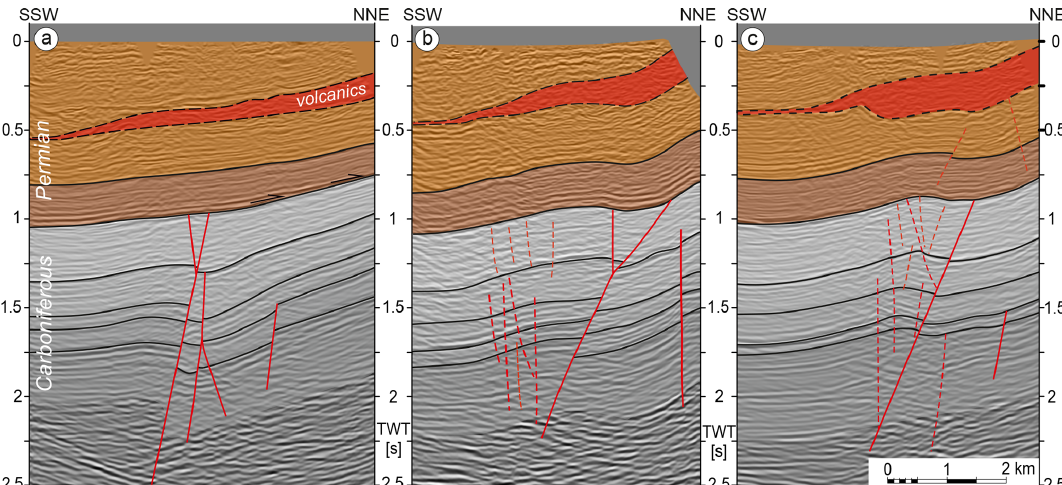
Figure 12. Seismic profiles from the vicinity of Mieroszów arranged successively along-strike of the structures from NW to SE, showing probable effects of Late Cretaceous–early Palaeogene reactivation of originally Carboniferous faults. The Permian volcanic member (in red) continues to the NNE to outcrop massively in the nearby Suche Mountains. Location in Fig. 11. The faults in (a) do not show effects of post-Carboniferous reactivation, but further to SE the motion on faults resulted in very gentle folding of the overlying Permian strata in (b) and (c)